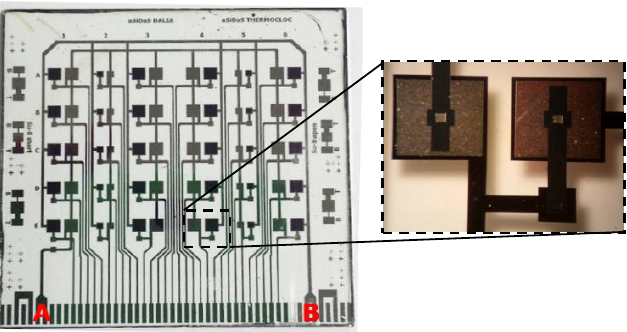
Figure 4. Picture of the 5 × 6 devices array on 5 × 5 cm 2 glass substrate. A and B indicate the electrical contacts to the positive and negative bias voltage respectively. The photo on the right is a microscopic view of a single device.